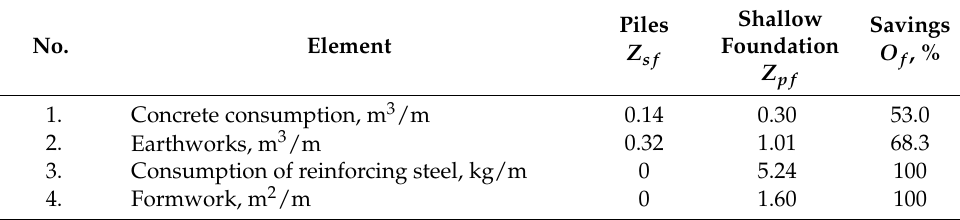
Table 9. Comparison of materials needed for performing